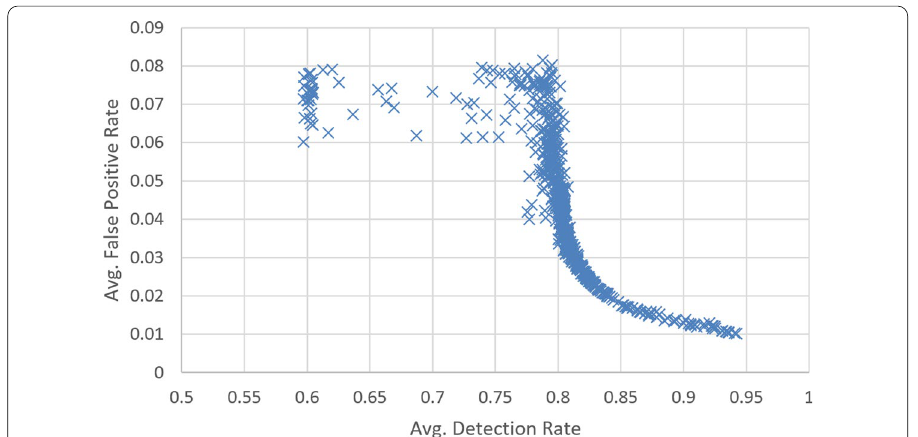
Fig. 5 Training performance of the proposed approach for DATASUBSET1